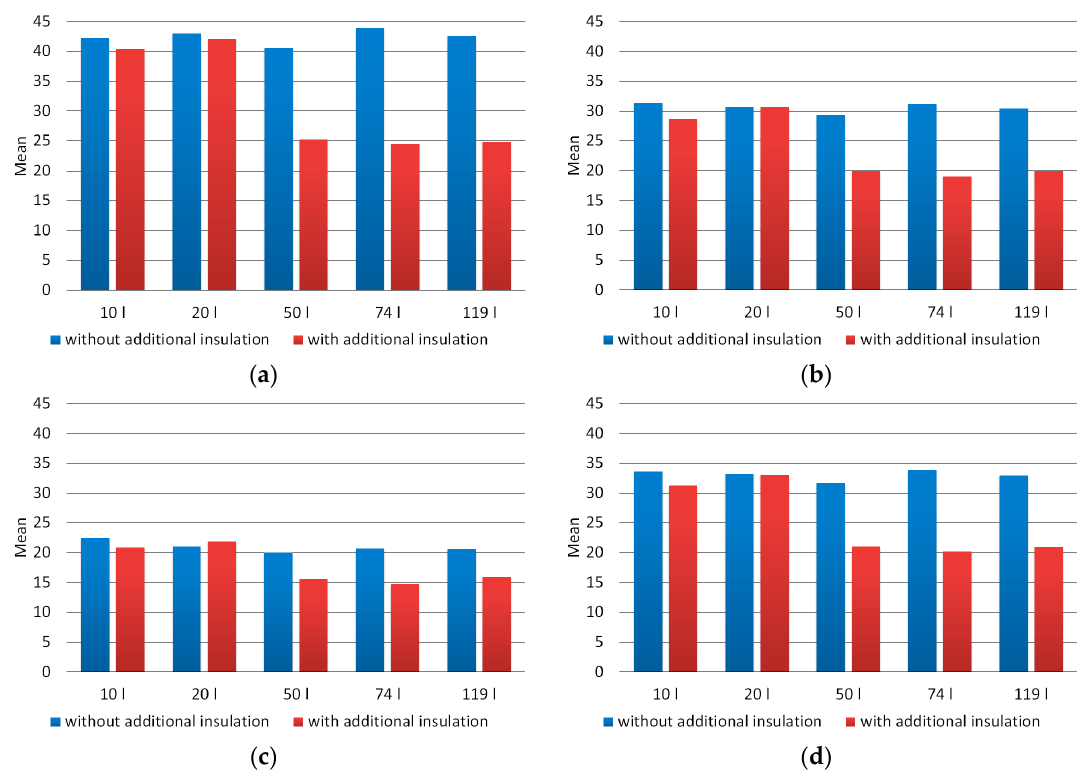
Figure 5. Mean brightness of the pixel averaged for images of composted material ( a )—component R, ( b )—component G, ( c )—component B, ( d )—grayscale.